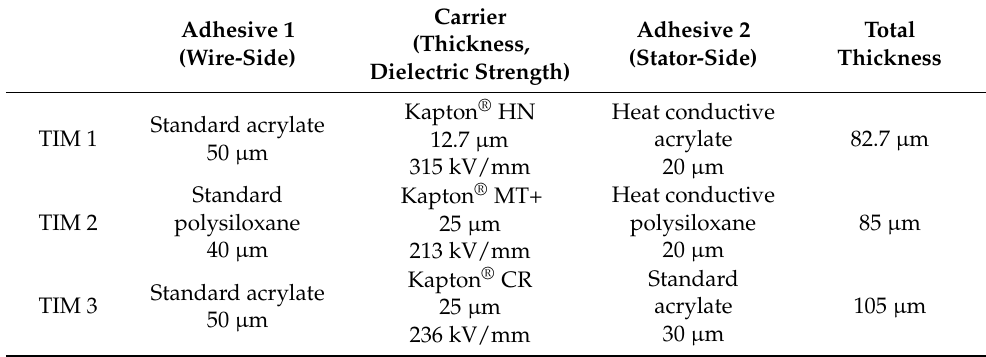
Table 1. Investigated adhesive tape